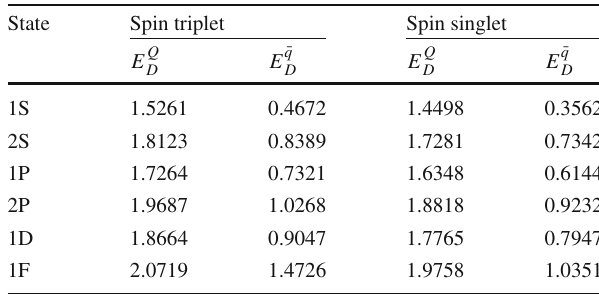
Table 15 The Dirac confinement energy (in GeV) of Quark (c) and anti-quark (u or d) for few ground and excited